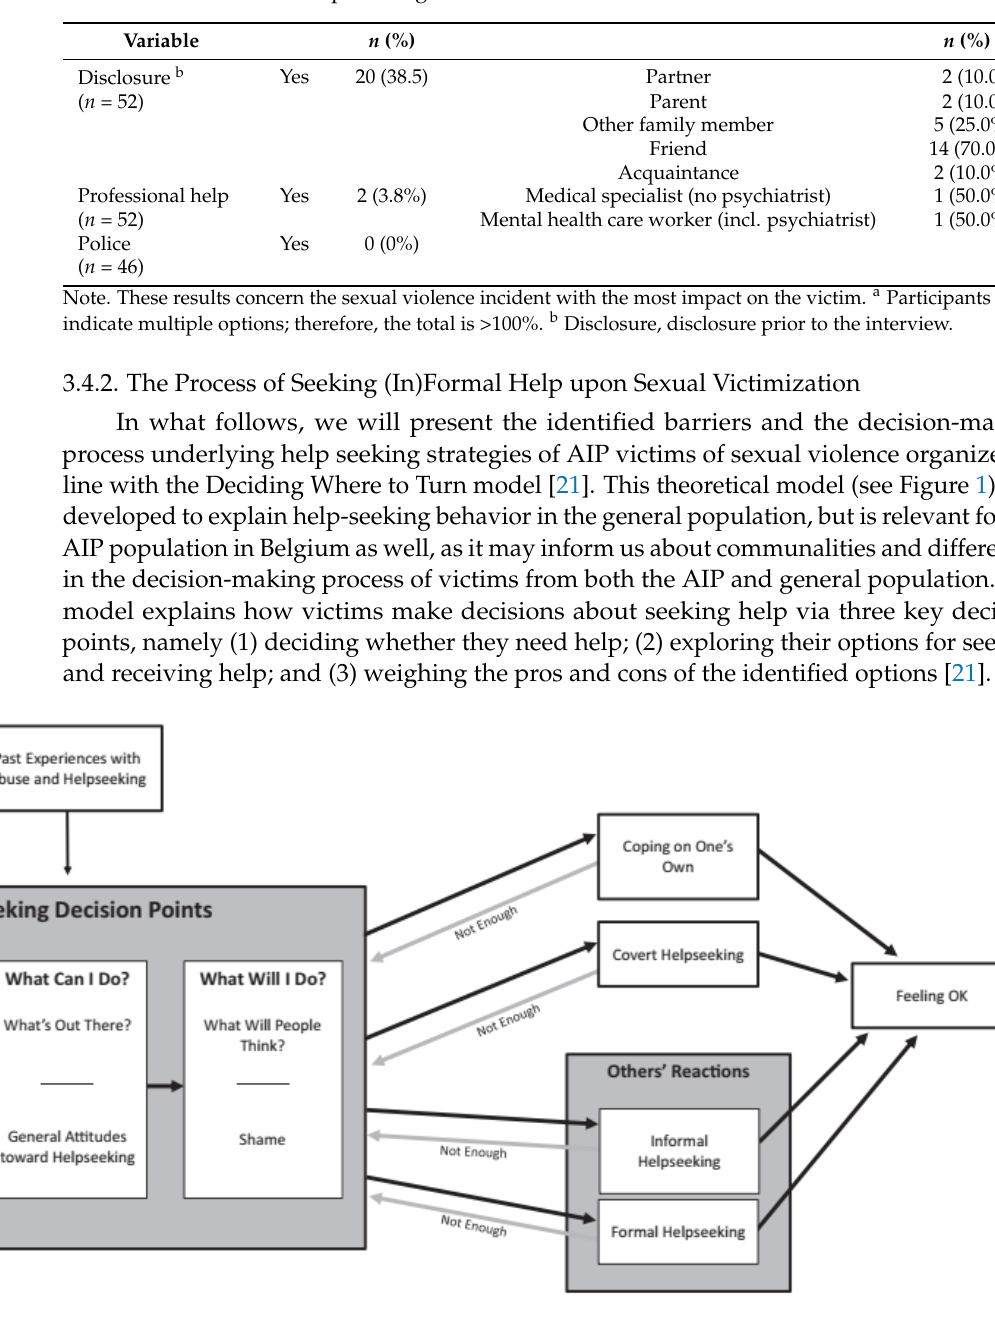
Figure 1. Deciding Where to Turn model. Reprint from Deloveh & Cattaneo (2017) [21]. The help-seeking decision points identified in this model are influenced by prior ex- periences with sexual victimization and help-seeking. The decision-making process can result either in coping with the victimization on one’s own, covertly seeking help, or overtly seeking help from either formal or informal sources of help. As long as victims do not feel ”ok” they may move back and forth between the key decision points and the cop- ing strategies [21]. Do I need help? All participants in the qualitative study were invited for participation and selected because they indicated they had been exposed to unwanted sexual experiences in the quantitative study. As such, they could all identify the unwanted nature of the incident(s) they were exposed to, although they did not necessarily all label their experiences as sex- ual violence. Regardless of the label they gave to their experiences, they recognized the impact it had on their lives and that the exposure to (in)direct sexual violence had affected them psychologically, physically, sexually, reproductively, and/or socioeconomically (see Section 3.3). Fatoumata (23 years old) explained that after being in Belgium for a while, she started to feel the need to talk about what had happened as she noticed that her be- havior, which was a consequence of the violence she experienced, was often wrongly in- terpreted by the people around her in the reception center. She said: “In Africa, I didn’t talk about it, but here [in Belgium] when I arrived, well like I needed someone who could hear me actually, who could understand what…when we are girl, I get angry from around me and they don’t even know what is going on now.” (Fatoumata, 23 years old) What can I do? The second key decision point relates to knowing the potential resources that are available and the general attitudes of victims toward seeking help upon victimization. Table 8 presents the barriers for help-seeking after sexual victimization identified in the quantitative study. AIP victims of sexual violence indicated in 4.8% of the cases that they did not know where they could turn to for receiving formal help or that professional help was not accessible because of financial or transportation limitations.